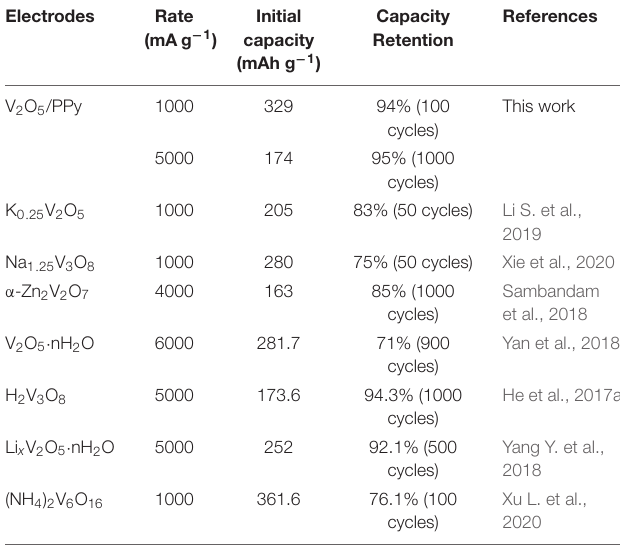
TABLE 1 | Comparison of the initial capacity and cycling stability of V 2 O 5 /PPy composite with recent literature data on vanadium oxide-based cathodes in aqueous ZIBs.